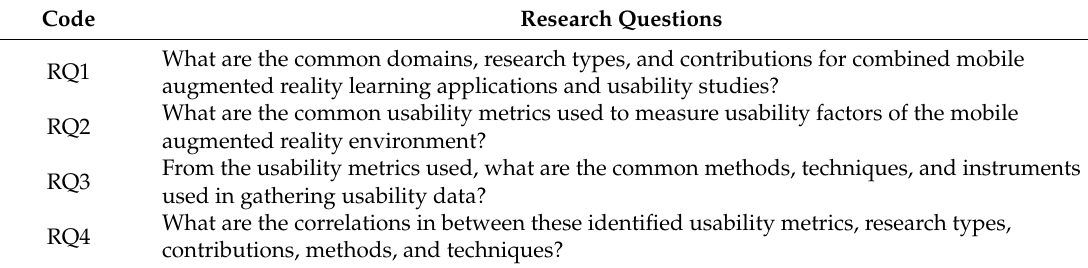
Table 1. List of research questions.